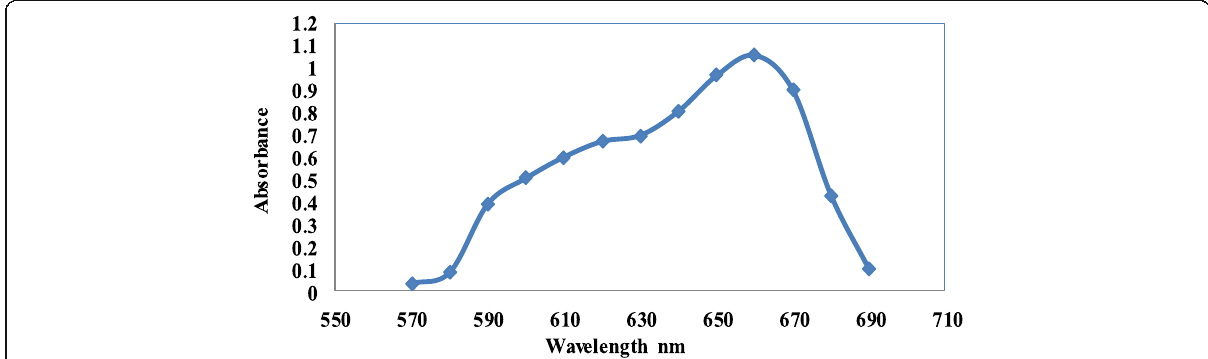
Fig. 2 Variation of absorbance of MB dye (100 mg/l) solution with